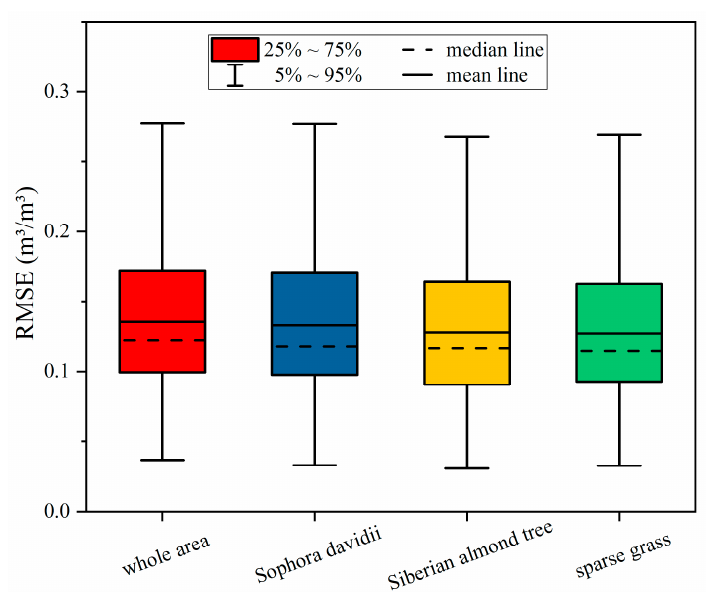
Figure Figure 8. The boxplot of downscaled SMs’ accuracy in the whole area and the single vegetation covers.